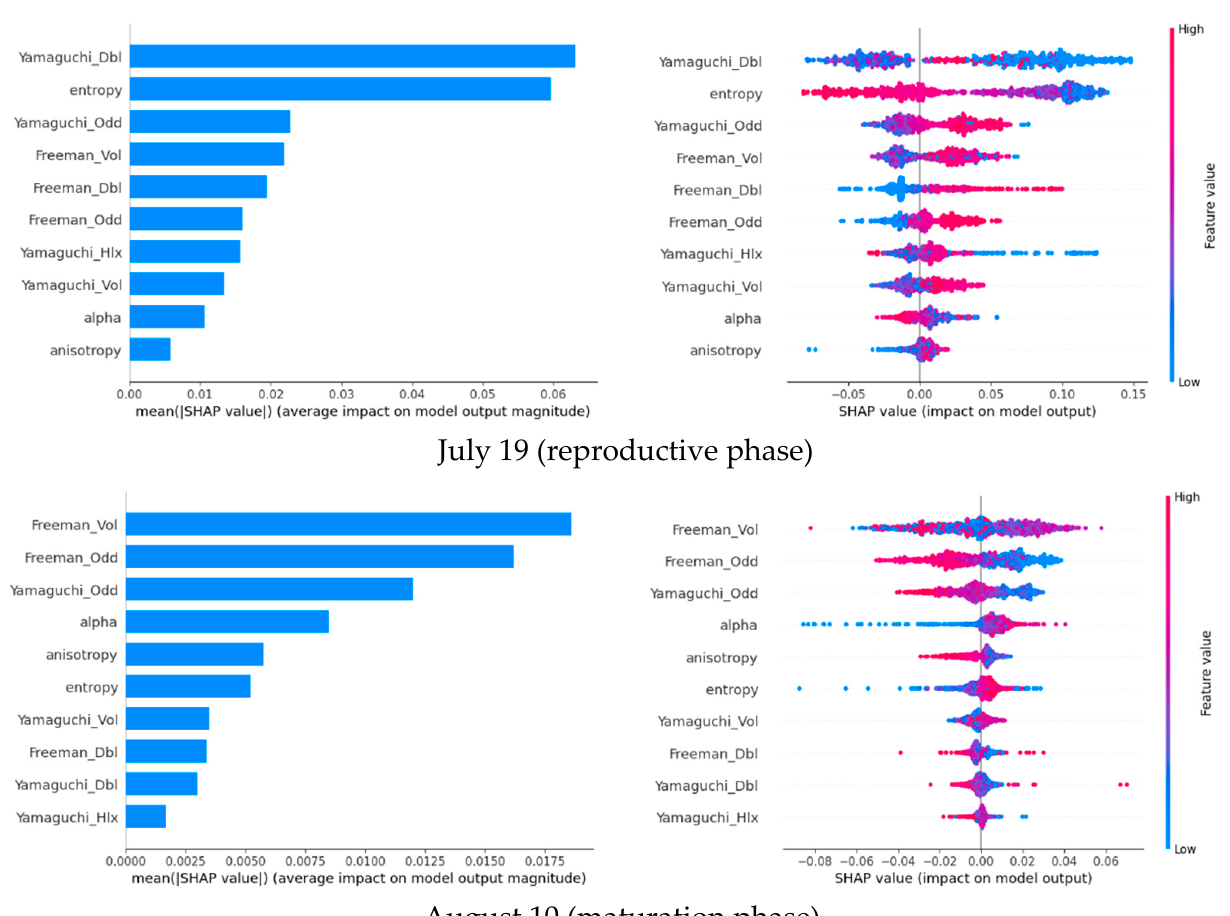
Figure 6. Physical feature importance histograms and scatter plots.